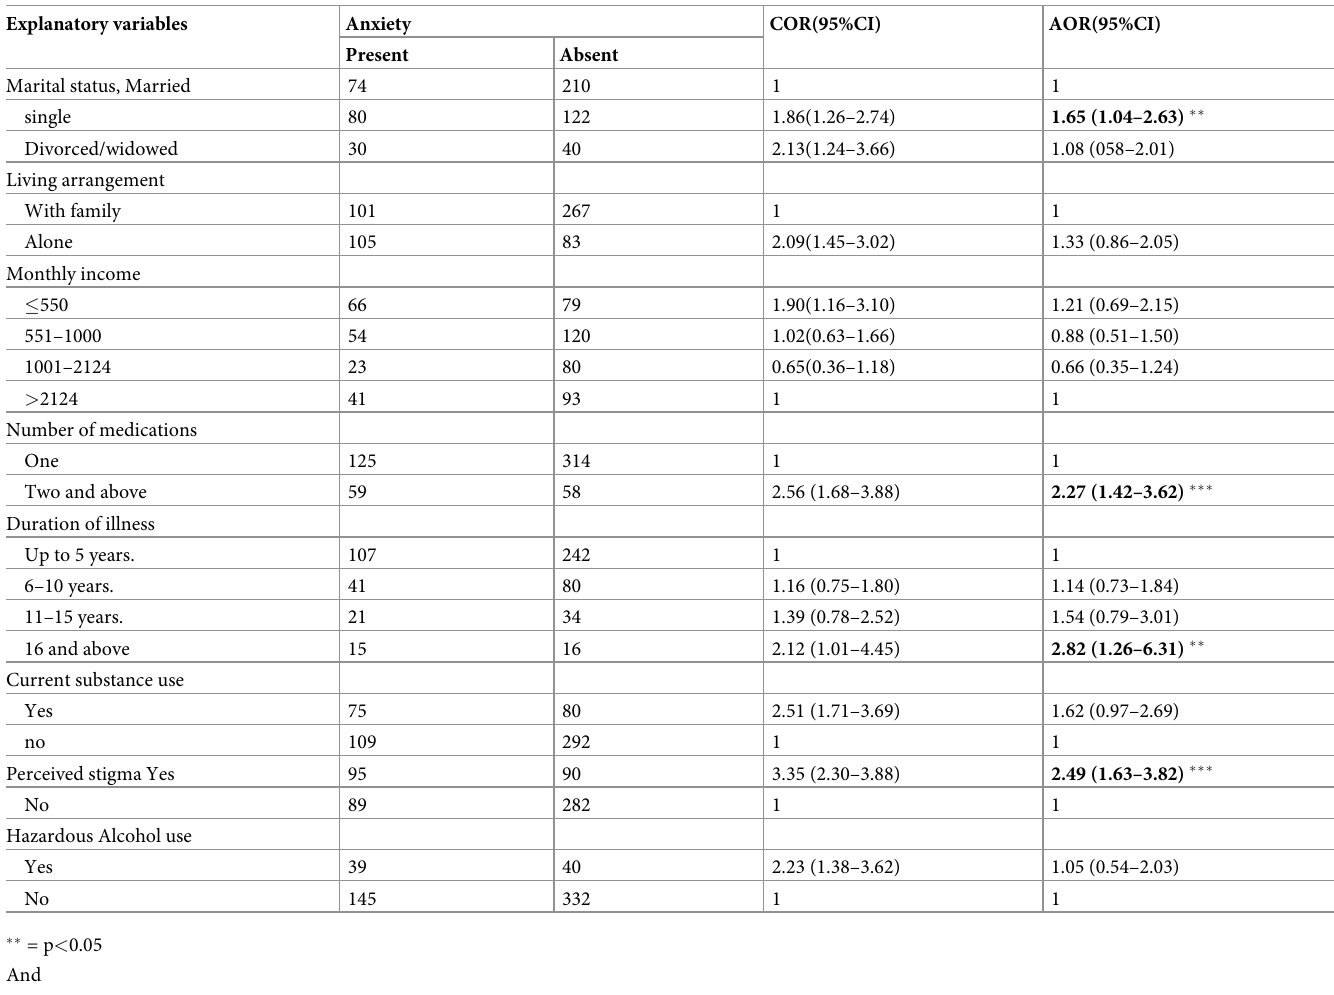
Table 4. Factors associated with anxiety in bivariate and multivariate logistic regression analysis among people with epilepsy at enteral Gondar zone primary public hospitals, northern part of Ethiopia (n = 556). Explanatory